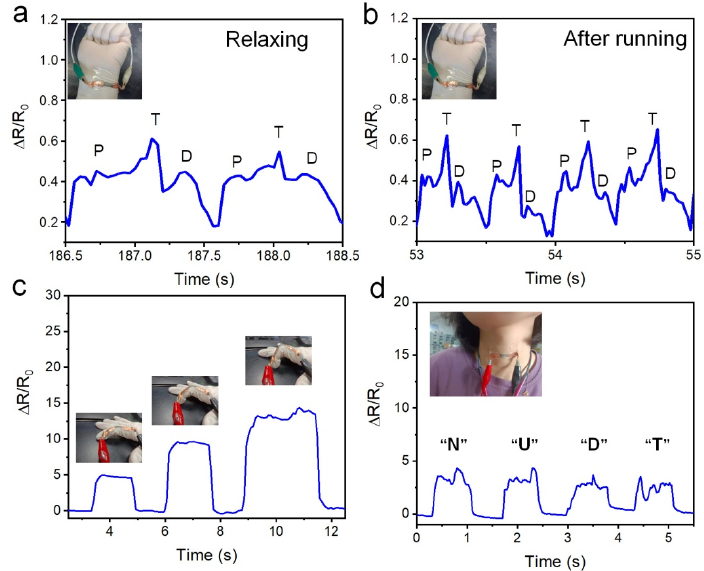
Figure 15. Demonstration of stripe-line PWG@R-5-60-based strain sensors detecting various human signals. ( a ) Wrist pulse in relaxation, ( b ) wrist pulse after running, ( c ) the bending of the finger, and ( d ) the pronunciation of different letters.